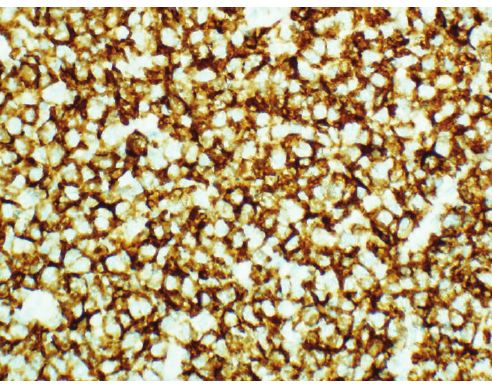
Figure 5: Strong and diffuse immunoreactivity for CD 20 (CD 20 Immunostain, × 400 magnification).